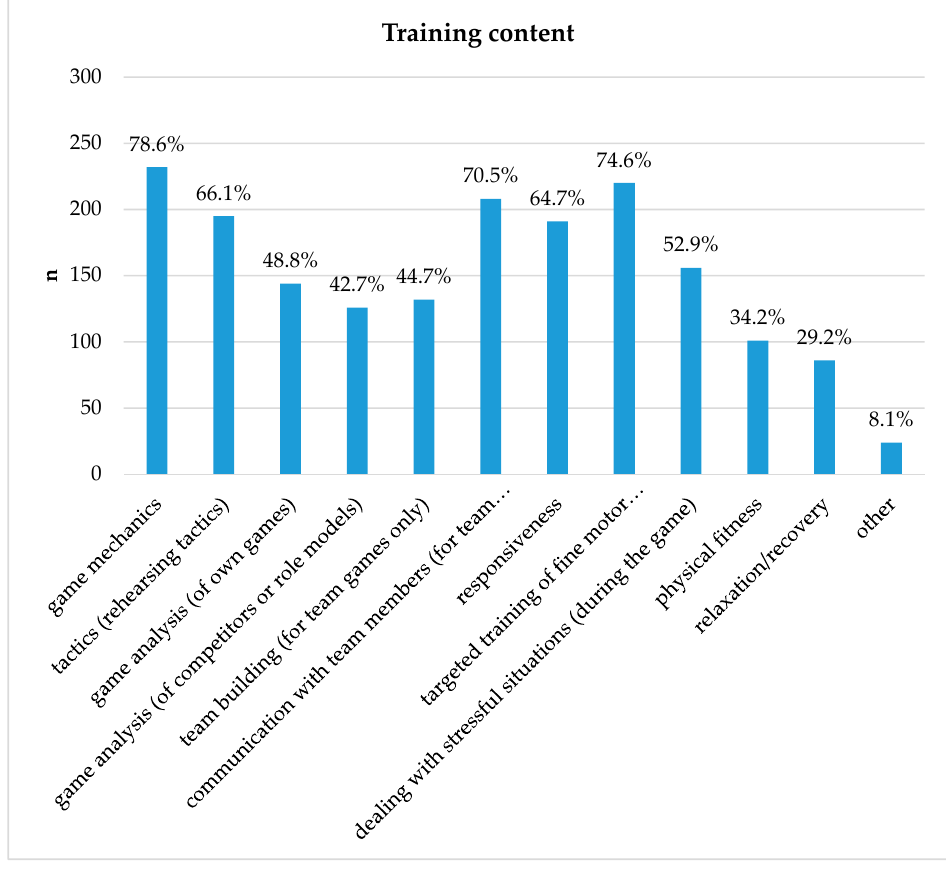
Figure 2. Content of players’ structured trainings ( n = 295). Values represent respondents who stated that they always train or often train for that aspect in their training